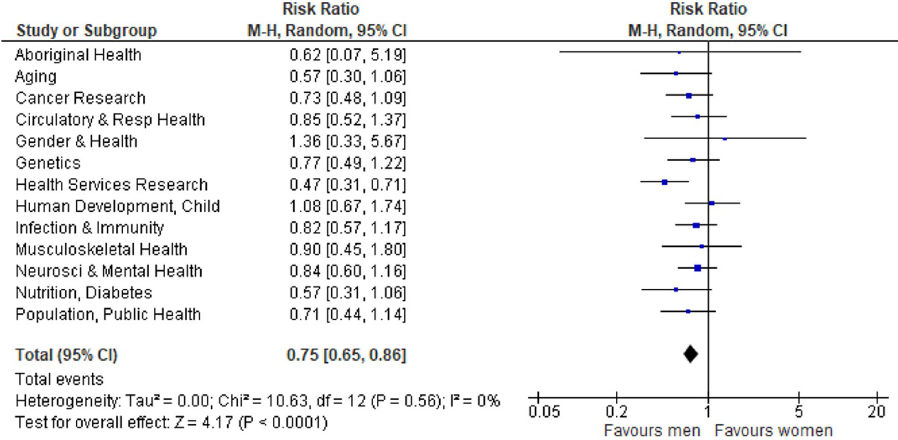
Fig 4. Forest plot of gender differences in new investigator success rates by designated research institute. CI, confidence interval; M-H, Mantel Haenszel.